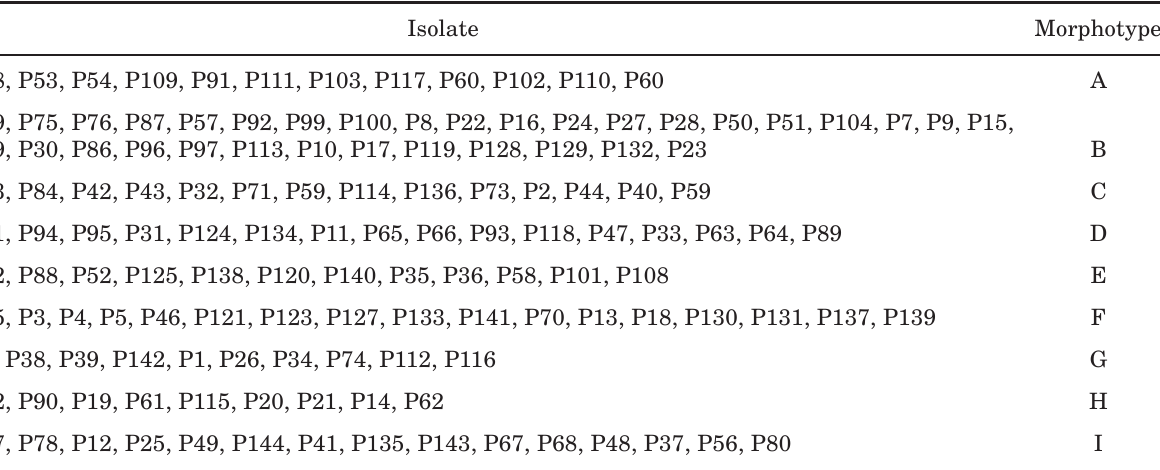
Table 4. Morphotypes identified among Phellinus torulosus isolates.